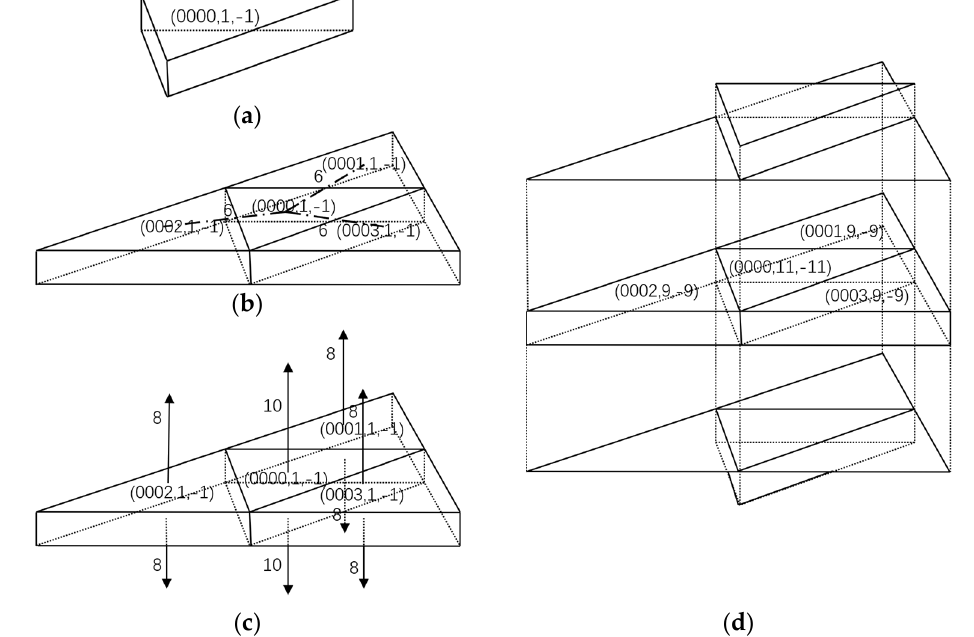
Figure 4. The radial elevation expansion of a cell. ( a ) The structure and the expansion direction of an initial cell; ( b ) The structure of the cells obtained by one edge neighbor expansion; ( c ) The radial elevation expansion direction of the cells; ( d ) The structure of the cells obtained by radial elevation expansion.